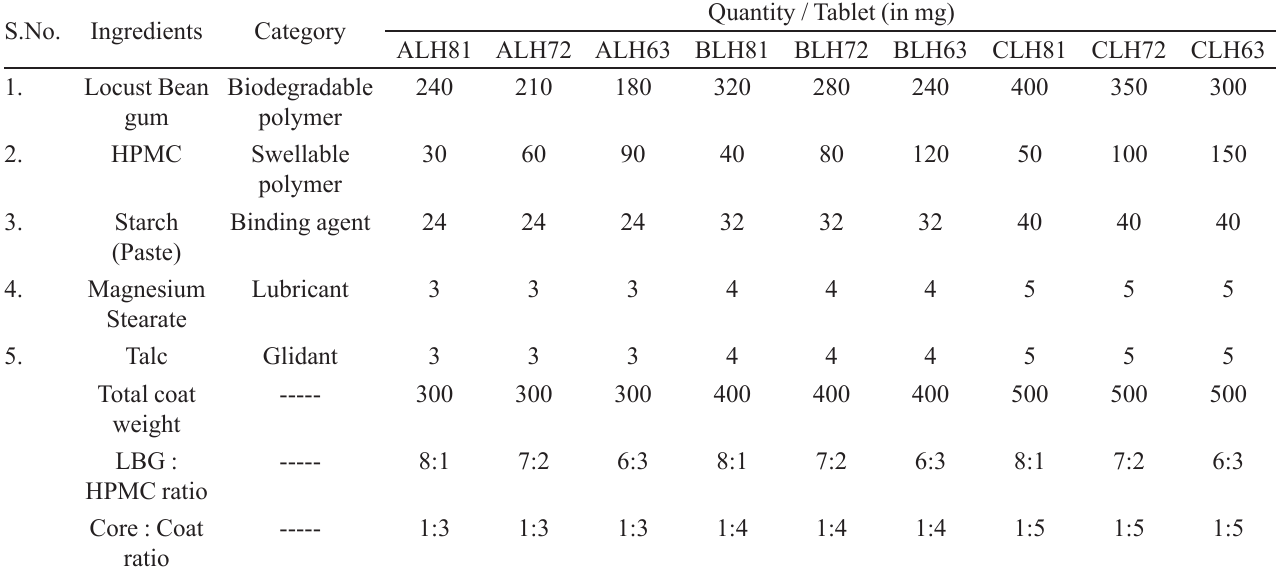
TABLE II - Composition of granular coat formulations for compression coating on 5-fluorouracil core tablets S.No.